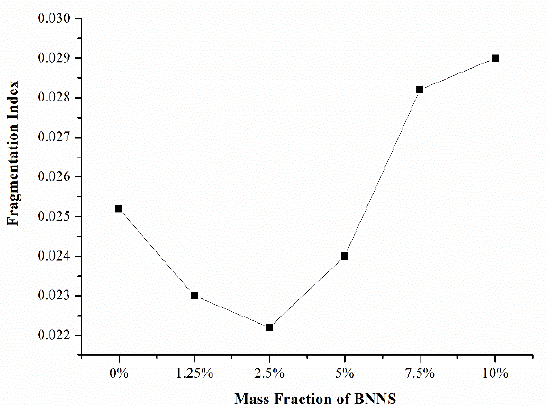
Figure 12. Fragmentation index of PI/BNNS systems with different doping ratios at a 200 kV/mm field intensity.